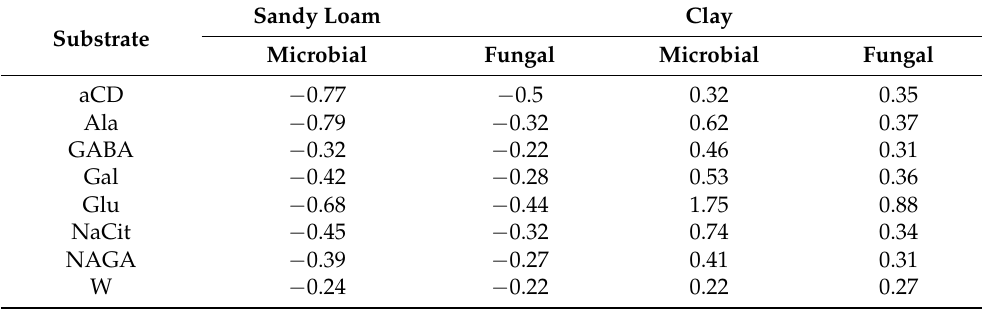
Table A2. Species weight for the principal response curves. Species represent the carbon